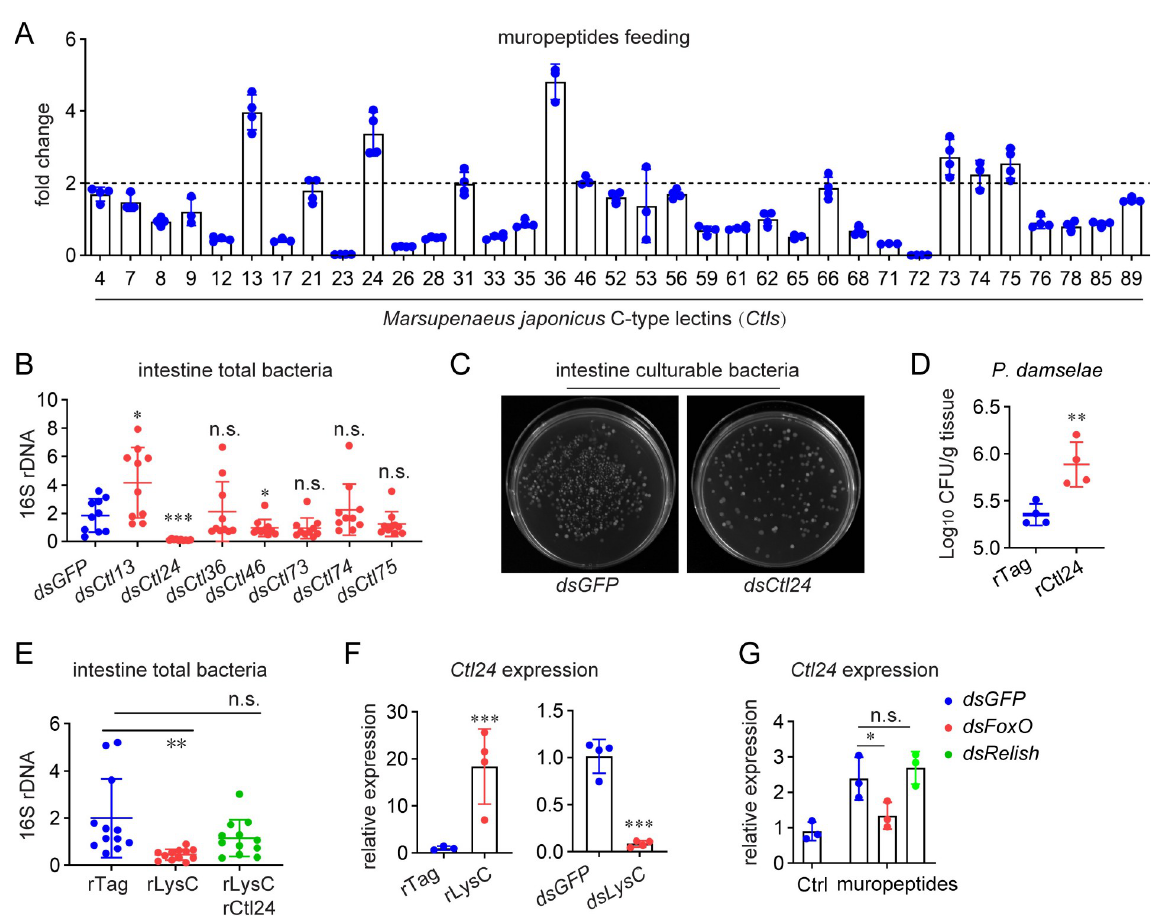
Fig 4. Counteracting role of Ctl24 to LysC. (A) Expression profiles of 34 C-type lectins in the intestines after oral treatment with muropeptides. Muropeptides (10 μ g) were introduced into intestines. Gene expression was detected by qRT-PCR 6 h later. (B) Influence of the abundance of intestinal total bacteria by knockdown of responsive Ctls . The bacterial abundance was determined by detecting 16S rDNA using qPCR 4 d after RNAi. (C) Influence of the abundance of intestinal total bacteria by Ctl24 knockdown. The abundance was determined using the plate-counting method. (D) Facilitating colonization of commensal bacteria P . damselae by rCtl24 in axenic intestines. Antibiotic-treated shrimp were orally delivered with a mixture containing 2 μ g of rCtl24 and 1 × 10 5 CFU of P . damselae . The bacterial amount was quantified 48 h later by detecting the ToxR gene using qPCR. (E) Influence of the abundance of intestinal bacteria by overexpression of rLysC, or rLysC and rCtl24. The bacterial abundance in intestine was determined by detecting 16 S rDNA using qPCR 3 d later protein (2 μ g) administration. (F) Regulation of Ctl24 expression by LysC overexpression or knockdown. Ctl24 expression in intestine was detected 12 h after rLysC (2 μ g) administration, or 24 h after LysC RNAi. (G) Expression of Ctl24 after FoxO or Relish knockdown and muropeptides challenge. Muropeptides (5 μ g) were introduced into intestines at 24 h after dsRNA application. Gene expression was detected another 6 h later. All bar charts show the mean ± SD from three replicates. The images are representative of three repeats. One dot represents one shrimp in the scatter graphs. Statistical analysis was performed using the Students’ t test. � , 0.01 < p < 0.05; �� , 0.001 < p < 0.01; ��� , p <